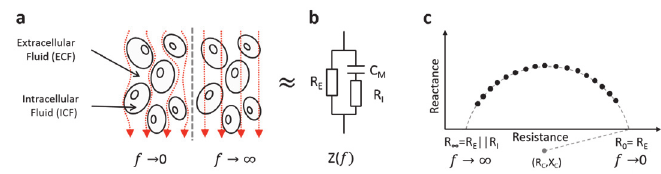
Figure 3. Principles of bioimpedance spectroscopy. (a) Flow of electrical current through biological tissue: low-frequency currents (f→0) flow around the cells through the extracellular fluid while high-frequency currents (f→∞) penetrate the cell membranes and flow through intracellular and extracellular fluid. (b) Simplified electrical circuit of the tissue bioimpedance consisting of two resistors and a capacitor accounting for the resistances of extracellular (R E ) and intracellular (R I ) fluids, and the capacitance of cell membranes (C M ), respectively. (c) Qualitative representation of bioimpedance spectroscopy measurement points (Z(f)) in the complex bioimpedance plane, the corresponding circular arc centered in (R C ,X C ), and the extrapolated values at low frequencies (f→0, Z(f)= R (cid:2868) = R (cid:2889) ) and high frequencies (f→∞, Z(f)= R (cid:2998) = R (cid:2889) ∥ R (cid:2893) ) according to the Cole model.